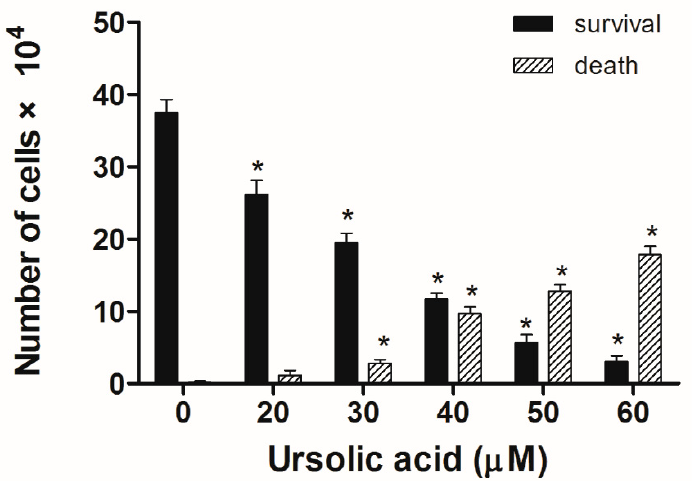
Figure 3. UA’s effect on cell survival and death in Huh-7 cells. The Huh-7cells were seeded in plates, then treated with different doses of UA for 24 h. Cell survival and cell death were analyzed using trypan blue staining. The survival and death of Huh-7 cells in UA was dose-dependent. The results were presented as means ± S.D. * p < 0.05; compared with the untreated controls.